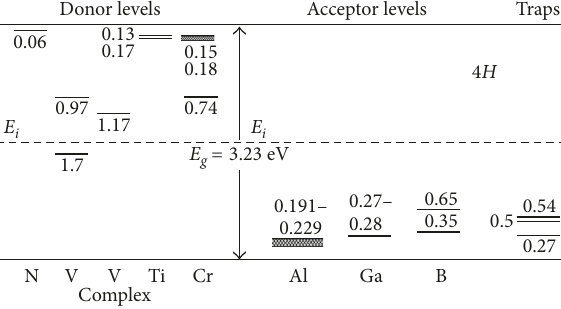
Figure 1: Levels of impurities and defects in 4 H -SiC